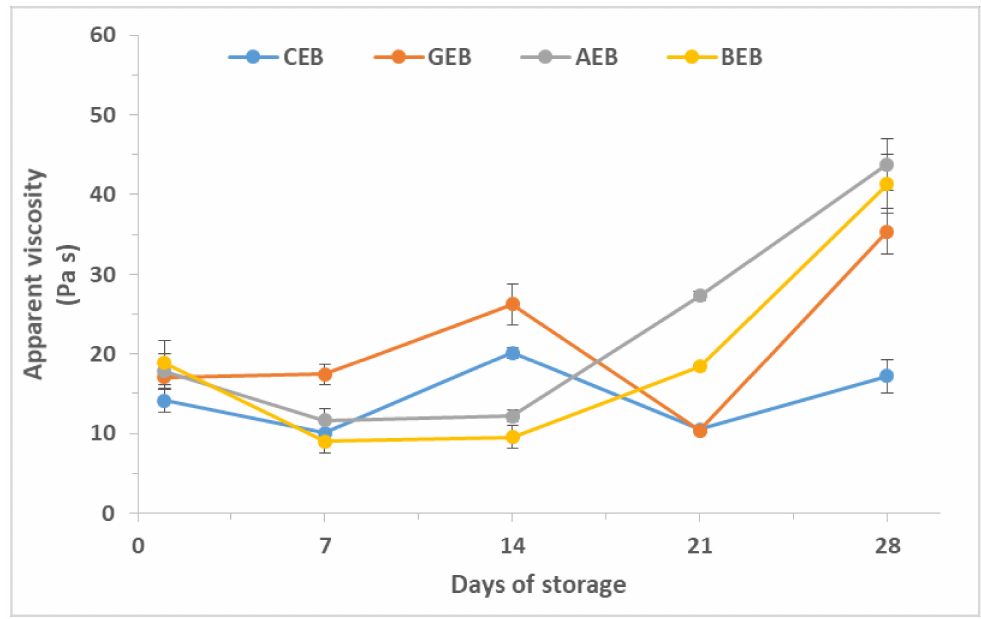
Figure 3. Apparent viscosity values, at 5 rpm, of beverages during storage (CEB: Control Emmer Beverage; GEB: Emmer Beverage with Grape juice; BEB: Emmer Beverage with Blueberry juice; AEB: Emmer Beverage with Aronia